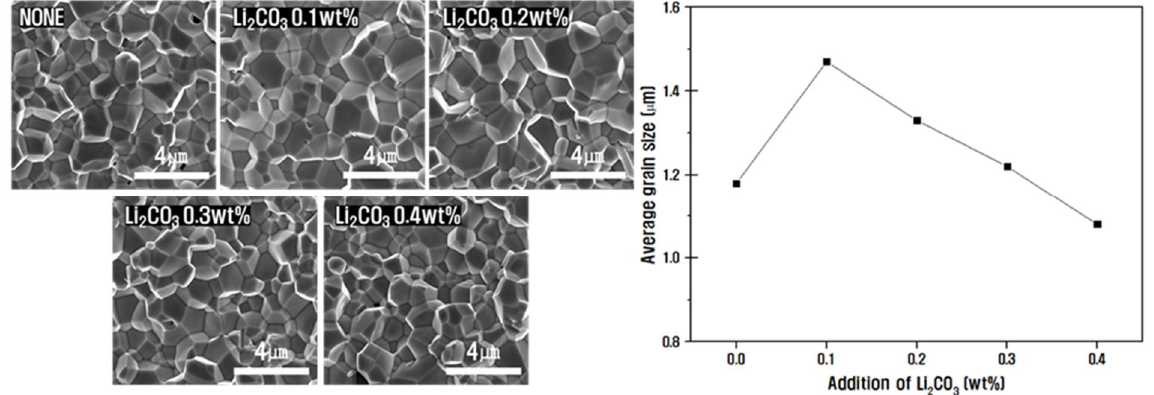
Figure 4. FE-SEM images of the fractured surface of PZNN-PZT ceramics with varying amounts of the Li 2 CO 3 dopant and the corresponding estimated average particle sizes.